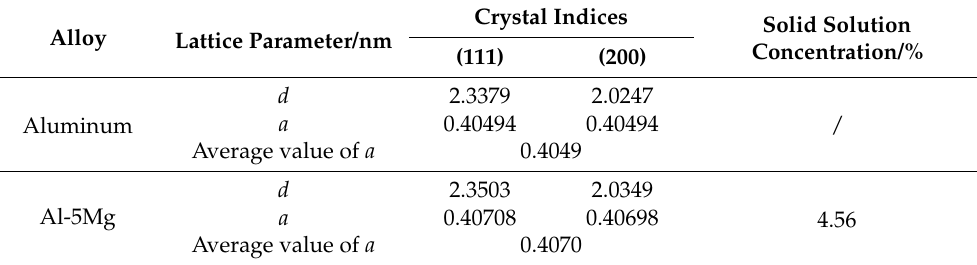
Table 3. XRD lattice parameter detection and solid solubility calculation results.